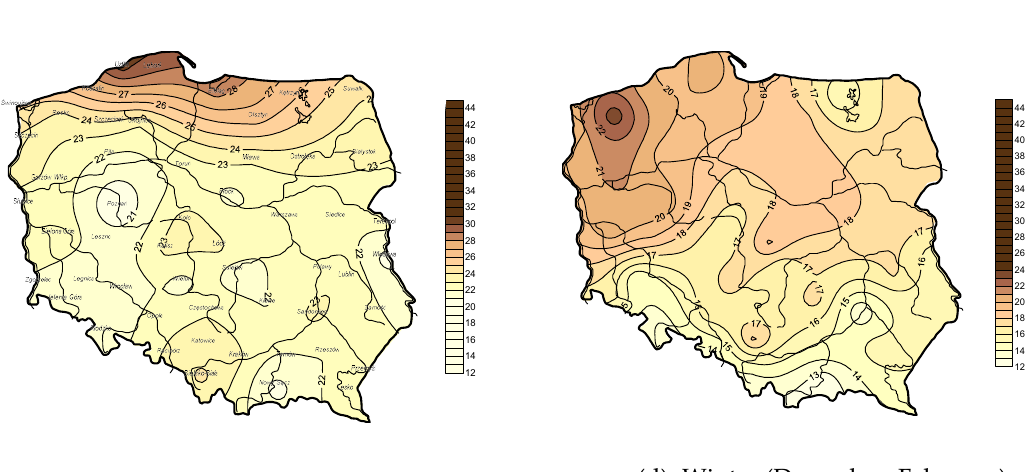
(c) Autumn (September–November) (d) Winter (December–February) Figure 5. Percentage share (%) of seasonal precipitation in the annual total in 2001 – 2018: (a) Spring; (b) Summer; (c) Autumn; (d) Winter.